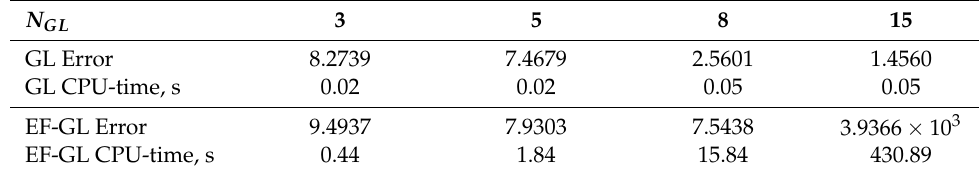
Table 2. Gauss–Laguerre (GL) and Exponentially-fitted Gauss–Laguerre quadrature (EF-GL) methods results, depending on number of nodes of the quadrature for Example